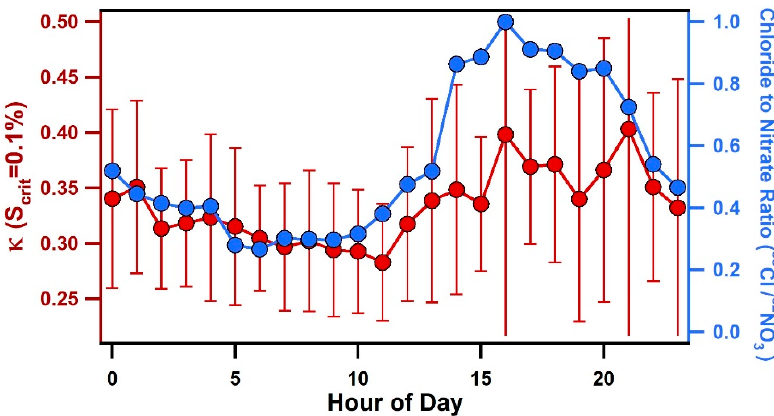
Figure 7. Diurnal profile of κ at 0.1% supersaturation with error bars representing the standard deviation and the chloride/nitrate ratio measured by ATOFMS.